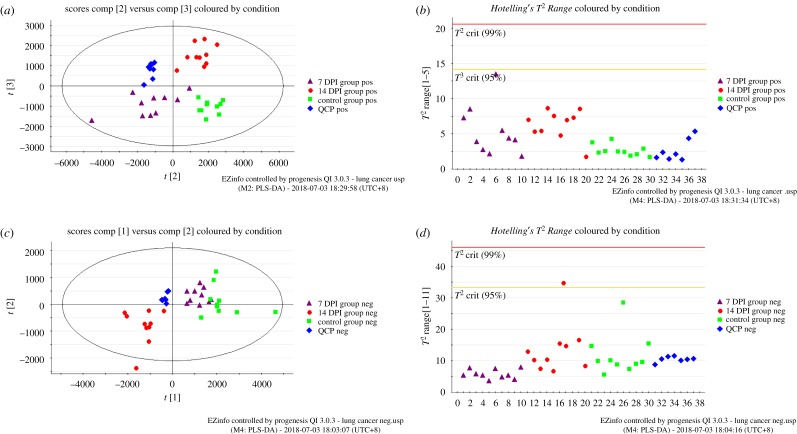
PCA score plot and Hotelling's T2 Range plot of all analysed samples in the 7 DPI model group, 14 DPI model group, control group and QCP samples. PCA score plot of all analysed samples in positive ion mode (a) with the statistical parameters (R2X = 94%, Q2 = 86%) and negative ion mode (c) with the statistical parameters (R2X = 97%, Q2 = 83%). The corresponding Hotelling's T2 Range plot in positive ion mode (b) and negative ion mode (d).